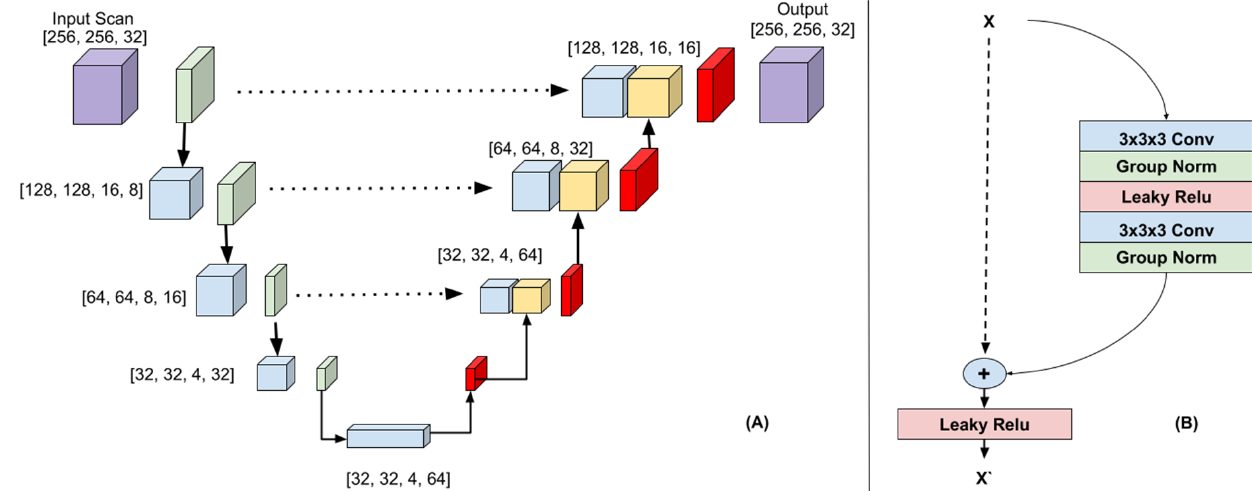
Figure A2. ( A ) 3D-Unet Architecture. The downsampling path (left) consisted of 3DResNet blocks with max pooling (green). The upsampling path (right) consisted of ResNet blocks followed by transposed convolutions (red). The features created in the downsampling path are colored blue and the features created in the upsampling path are colored yellow. The dotted arrows indicate the skip connections. The feature maps from the downsampling path were concatenated to the feature maps in the upsampling path. The input image and output probability map are colored purple. ( B ) 3D ResNet block. Table A2. Lesion location in the posterior fossa, which was scored manually by using the PC-ASPECTS. Table A1. Imaging parameters used to acquire the NCCT scans of the included patients from the BASICS trial. Imaging parameters were missing for two patients.